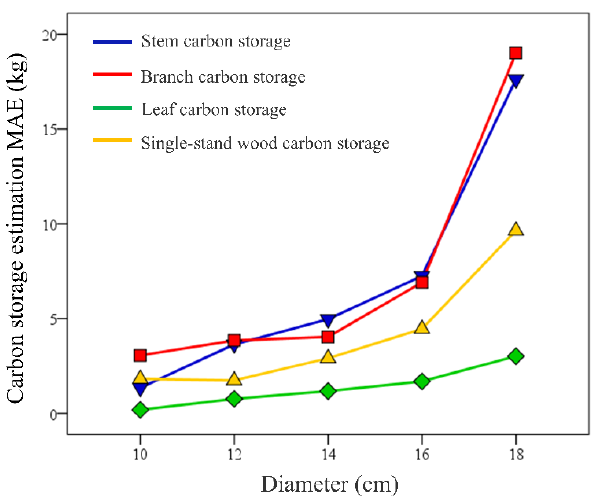
Figure 8. Variation in the carbon stock accuracy of each organ, and the overall carbon stock measured via existing models by increasing